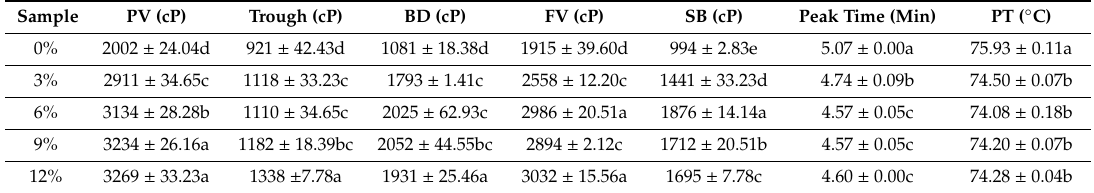
Table 2. RVA (rapid visco analyzer) properties of corn starch as a function of di ff erent levels of gum Cordia